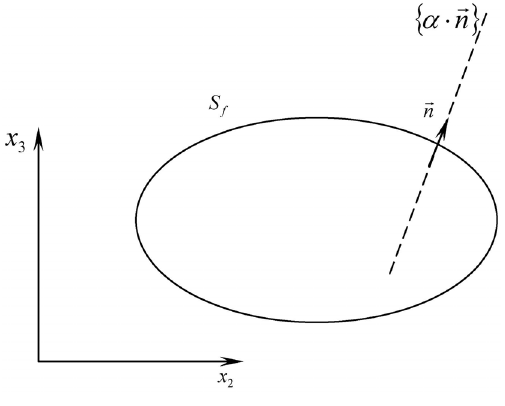
Figure 9. Local boundary ( constx =